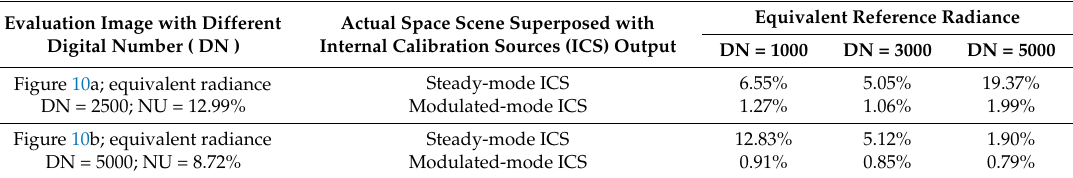
Table 1. Non-uniformity correction results of the evaluation images. Table 1. Non ‐ uniformity correction results of the evaluation images.